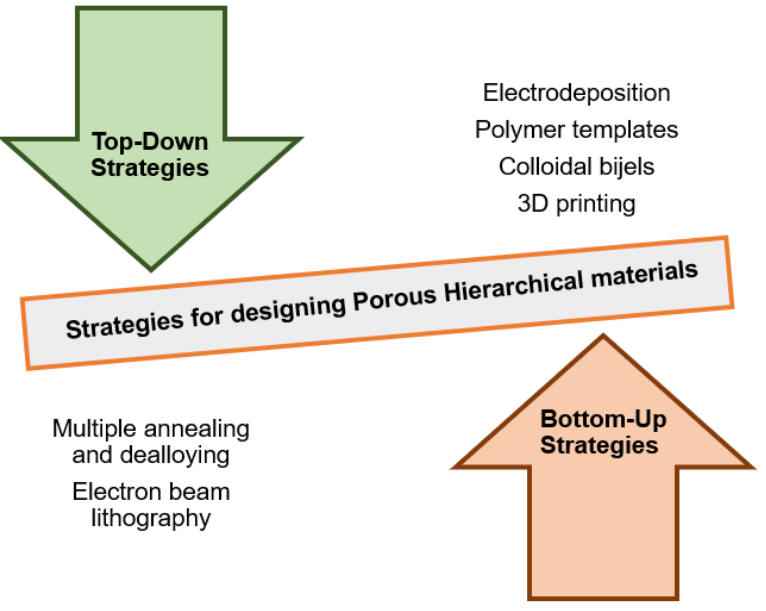
Figure 2. Diagram showing the common methodologies under the top-down and bottom-up ap- proaches.